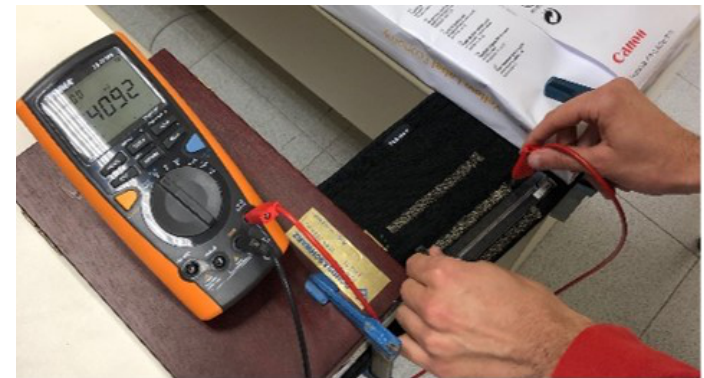
Figure 4. Strain sensor characterisation